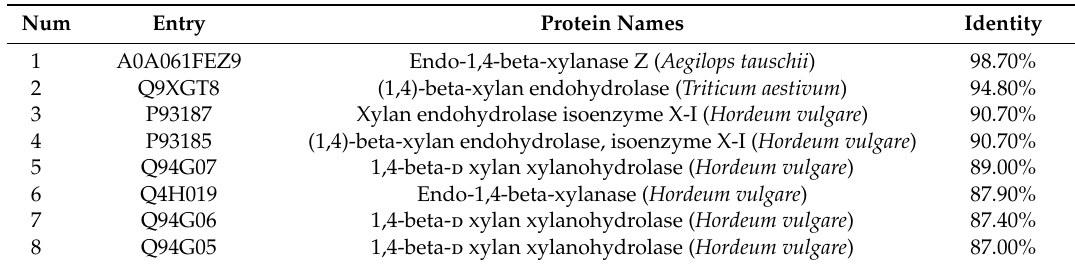
Table 3. Similar proteins Information of A0A3B6MY89 in the UniProt database.